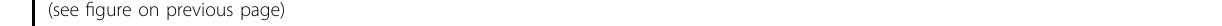
Fig. 5 MiR-577 suppresses proliferation and metastasis via targeting HSP27 in CRC cells. a , b Up-regulation of miR-577 inhibited HSP27 expression, while the inhibition effect was reversed by pcDNA3.1-HSP27-mut, but not by pcDNA3.1-HSP27-wt, as determined by western blotting ( a ) and qRT-PCR ( b ). & P > 0.05, ** P < 0.01 vs. the pre-miR-577 group. c , d Up-regulation of miR-577 suppressed HT29 ( c ) and LOVO ( d ) cell proliferation, while the suppression effect was reversed by pcDNA3.1-HSP27-mut, but not by pcDNA3.1-HSP27-wt, as determined by the EDU and CCK8 assays. &P > 0.05, **P < 0.01 vs. the pre-miR-577 group. e , f Elevation of miR-577 also suppressed HT29 ( c ) and LOVO ( d ) cell metastasis, and the suppression effect was reversed by pcDNA3.1-HSP27-mut, but not by pcDNA3.1-HSP27-wt, as determined by the Transwell assay. & P > 0.05, ** P < 0.01 vs. the pre- miR-577 group (Nos. 1 – 4 represent the control group, pre-miR-577-NC group, pre-miR-577 group, pre-miR-577 + pcDNA3.1-HSP27-wt group and pre-miR-577 + pcDNA3.1-HSP27-mut group, respectively). The data are shown as the means ± SD from three independent